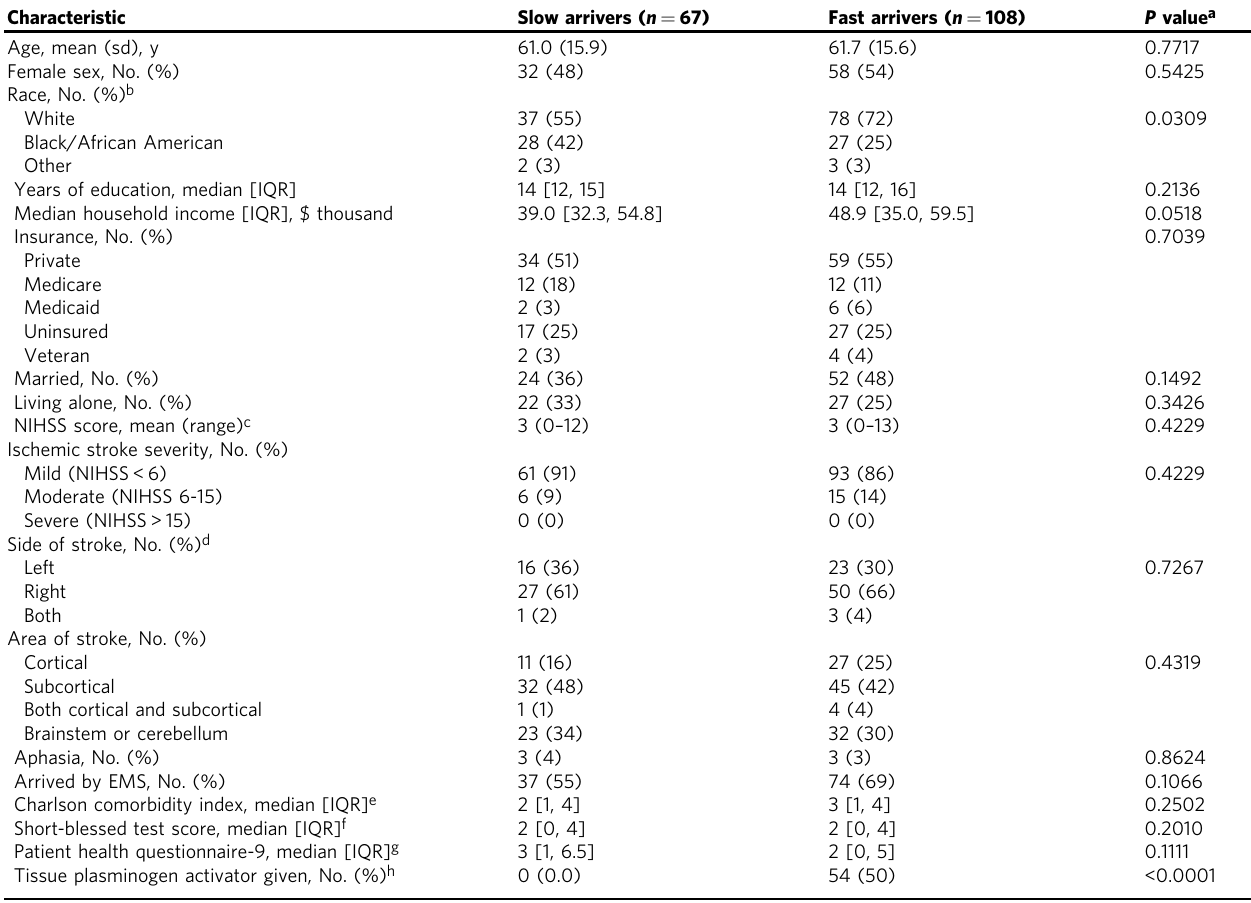
Table 1 Baseline characteristics of patients, according to arrival time